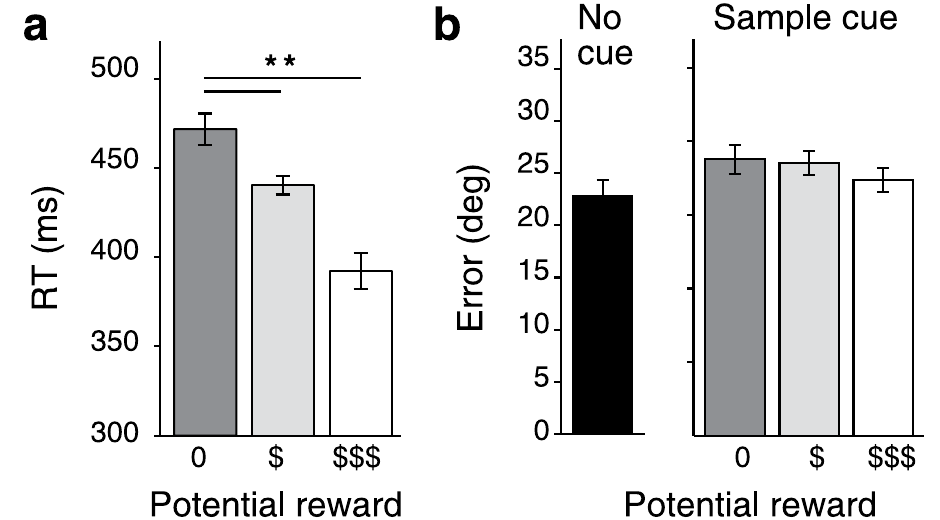
Figure 5. Results of Experiment 5. ( a ) Results of the color-reward association task of Experiment 5 averaged over all participants ( n = 8). Correct color reports were generally faster for colors associated with higher rewards. ( b ) Results of the working memory task of Experiment 5 ( n = 8). The error between the reported and the remembered orientation was not affected by colored rings in the Sample phase that predicted the potential rewards. Error bars represent within-subjects s.e.m.’s 88 . Asterisks indicate significance levels for pairwise comparisons among target categories ( ** p <